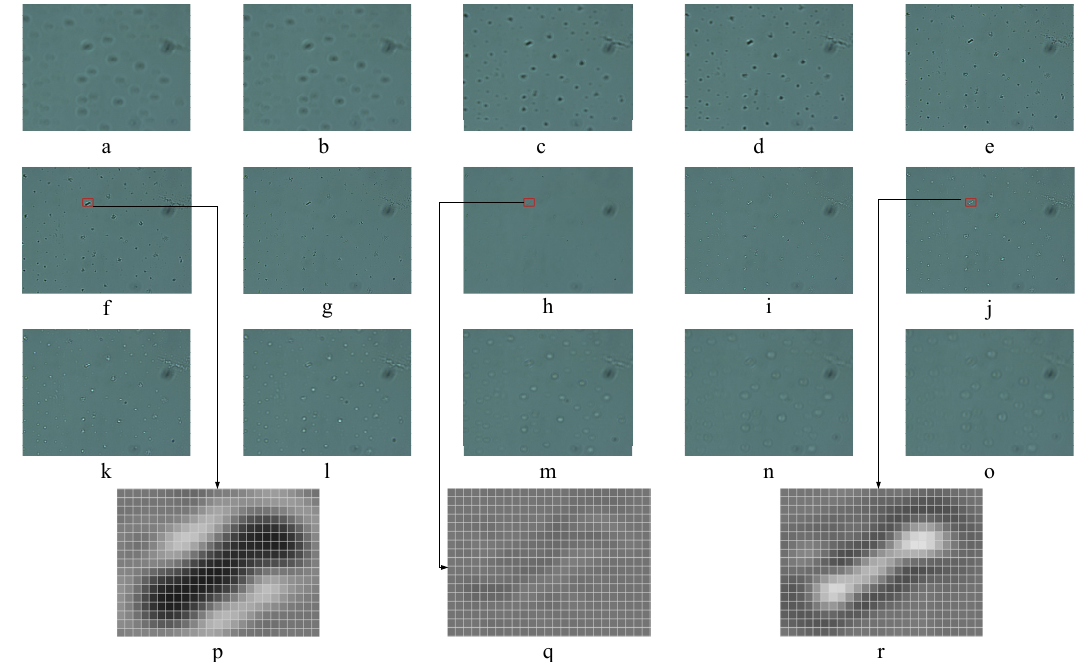
Figure 3. Microscopic image in focus process: ( a – o ) represent the sequence of microscopic images from defocused to focused and then to defocused in the focus process; ( h ) is the image that lens is at real focus position f r . ( f , j ) are the images that lens is at two different pseudo focus positions f p 1 , f p 2 . ( p , q , r ) are locally enlarged pixel-wise gray image of ( f , h , j )